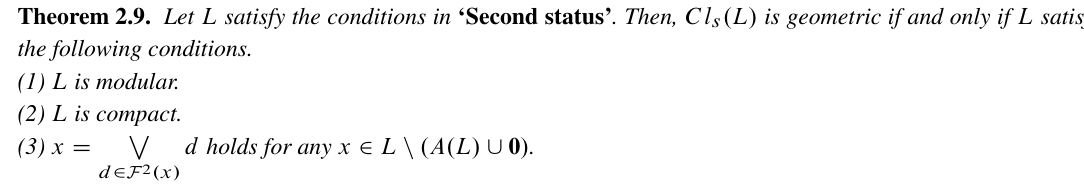
Figure 5 diagram of L Cl s .L 2 /